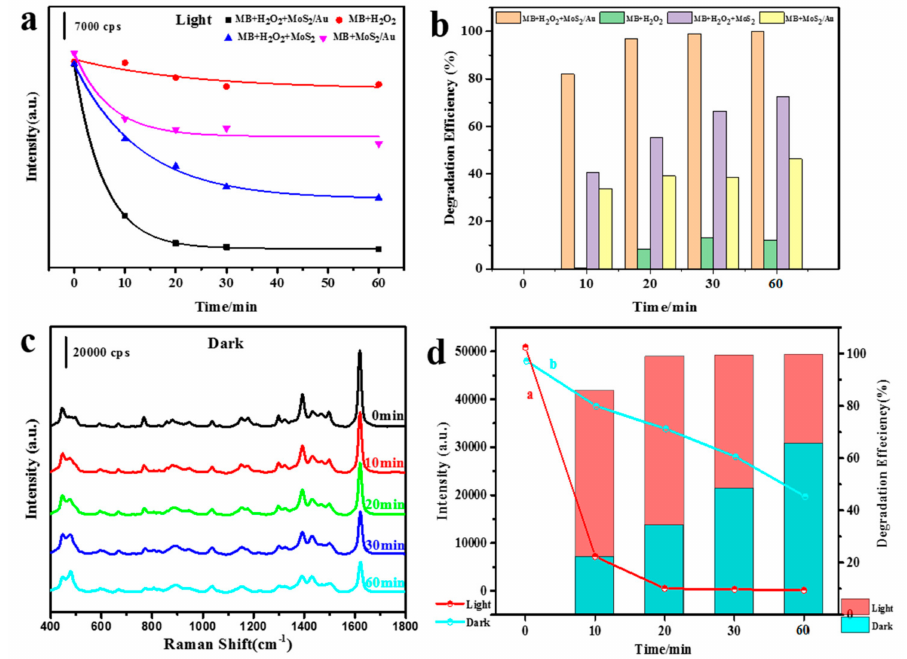
Figure 5. SERS intensity from the band at 1623 cm − 1 as a function of reaction time catalyzed by MoS 2 /Au or MoS 2 in different conditions under natural light ( a ) and corresponding catalytic effi- ciencies ( b ); Time-dependent SERS of degradation of MB by MoS 2 /Au (in dark) ( c ); Time-dependent SERS intensities and degradation efficiencies in dark and natural light ( d